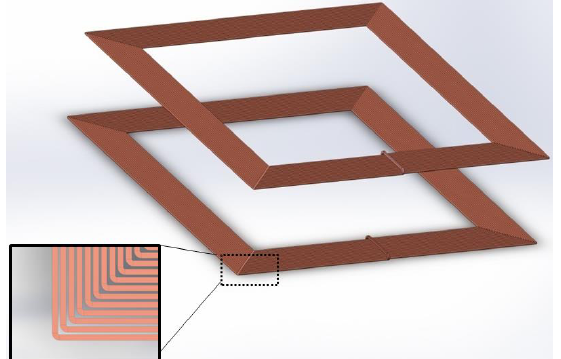
Figure 6. CAD model of the WPT system.